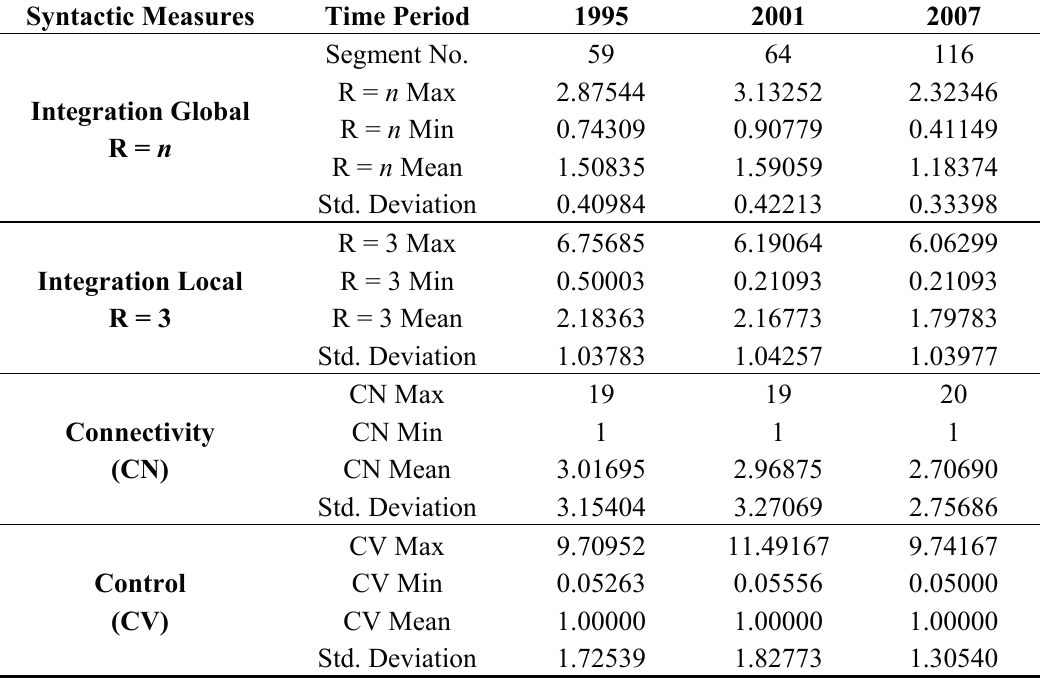
Table 3. Syntactic measures of ward 18 (Baridhara) in different time